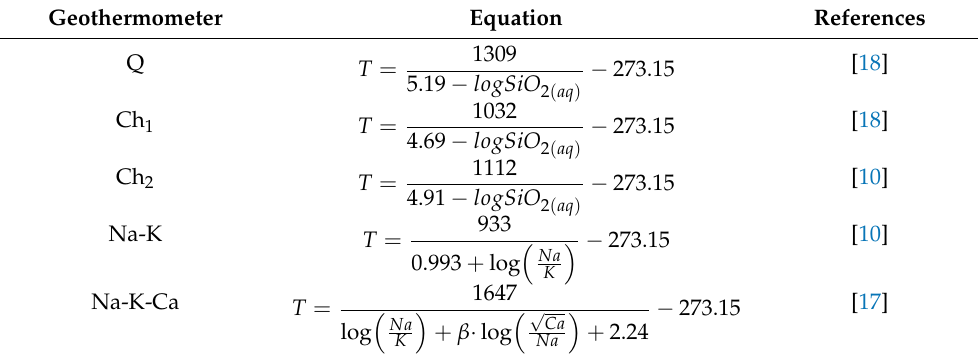
Table 2. Expressions for different